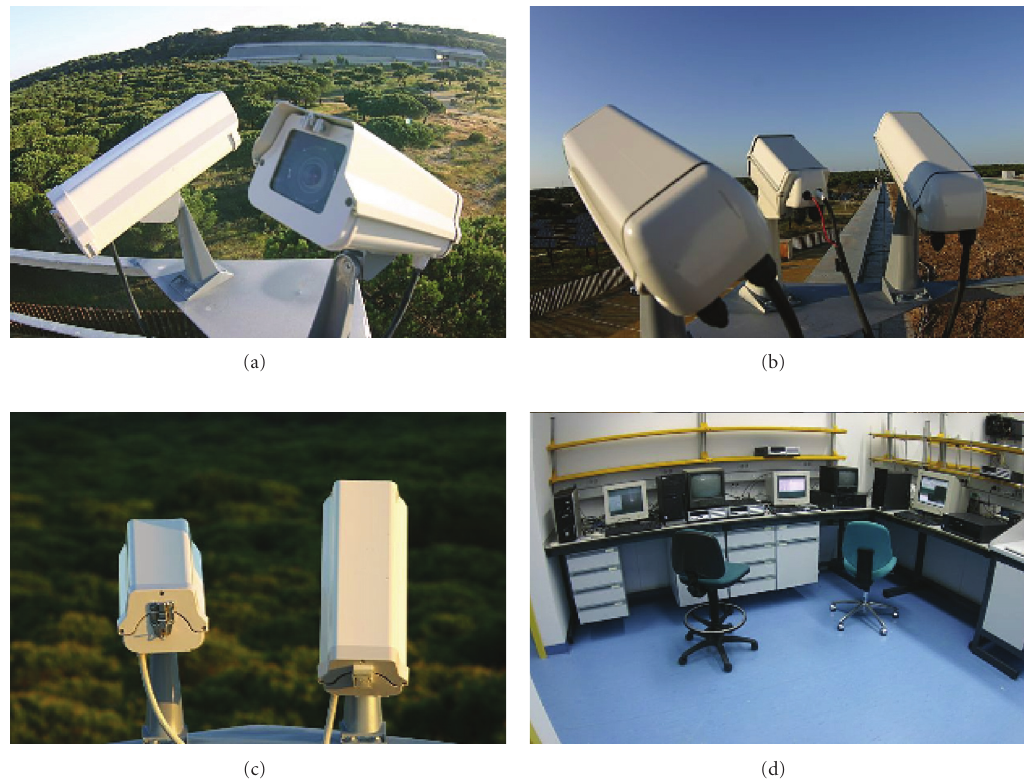
Figure 1: Images of the control room and some of the high-sensitivity CCD video cameras operating from the astronomical observatory setup by the University of